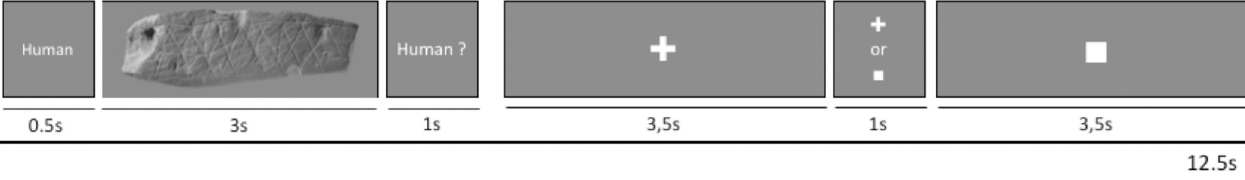
PLOS ONE | https://doi.org/10.1371/journal.pone.0271732 August 3,